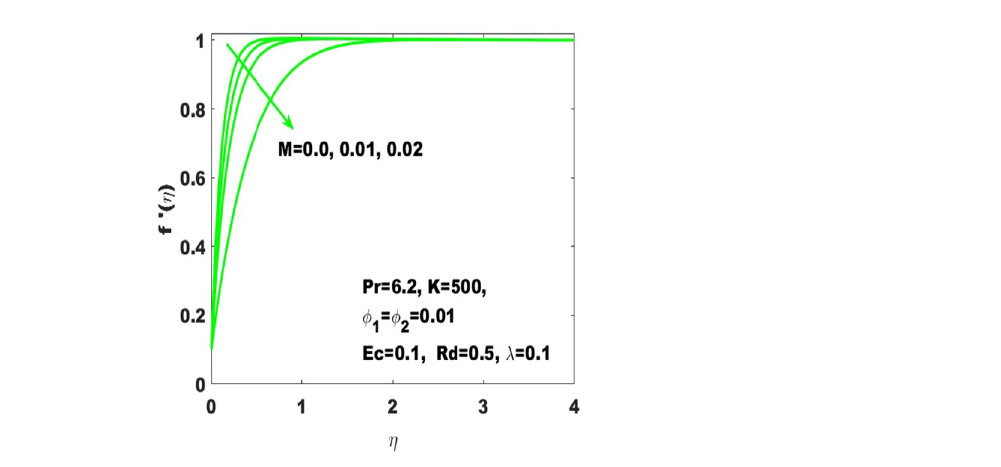
′ ( η ) Figure 13. f for the diverse values of